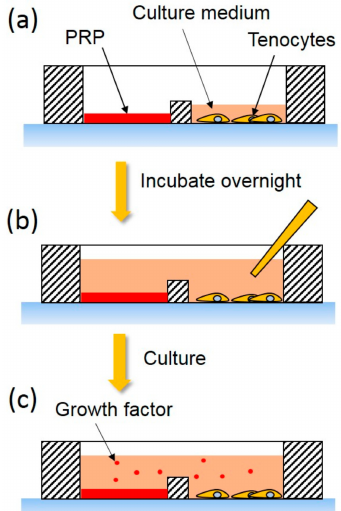
Figure 4. Experimental protocol of the investigation of the proliferation of tenocytes co-culturing with the PRP. ( a ) The PRP and the tenocytes were respectively seeded on the sub-chambers of the device and incubated overnight. ( b ) The culture medium was added to the culture well; therefore, the PRP and the tenocytes were co-cultured in the interlinked medium. ( c ) The platelet-derived growth factors diffused to the medium and affected tenocyte